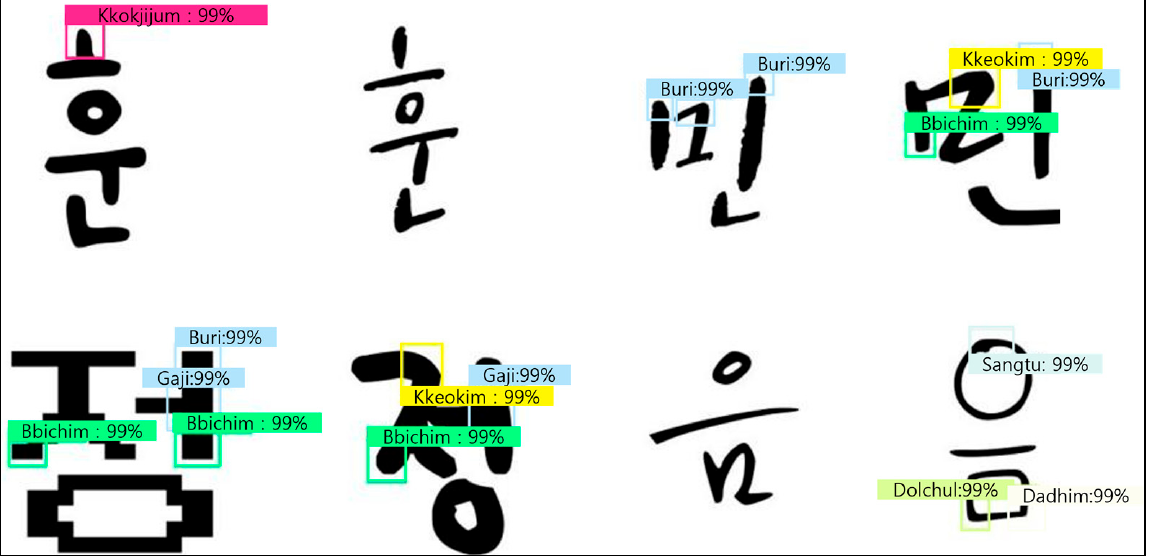
Figure 10. An example image of the detection result of Group C.